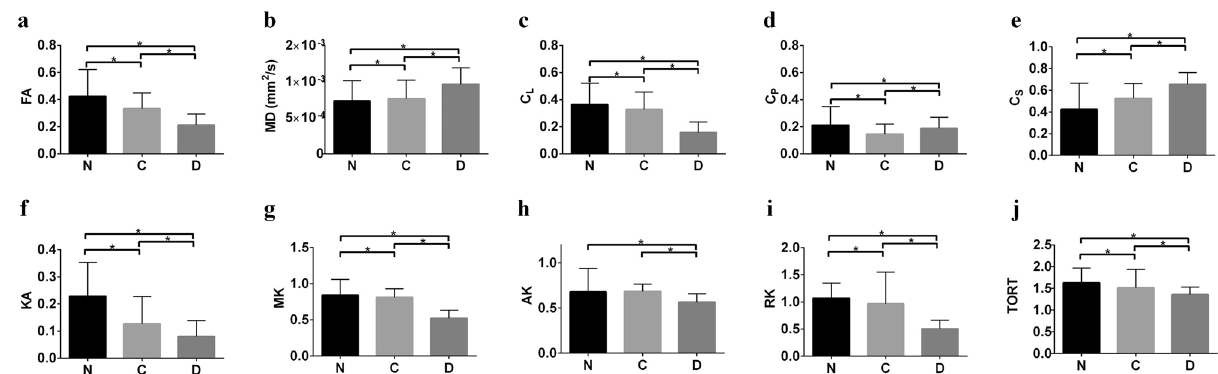
Figure 6. Comparative analysis of DTI based tensor shapes among ( a ) native, ( b ) collagenase treated and ( c ) decellularized tissue samples using HAR protocol. The diffusion/tensor profile is represented using barycentric space (3P). For this assessment, C L, C P and C S were estimated from high angular-resolution DWI (b ≤ 800 s/ mm 2 ).